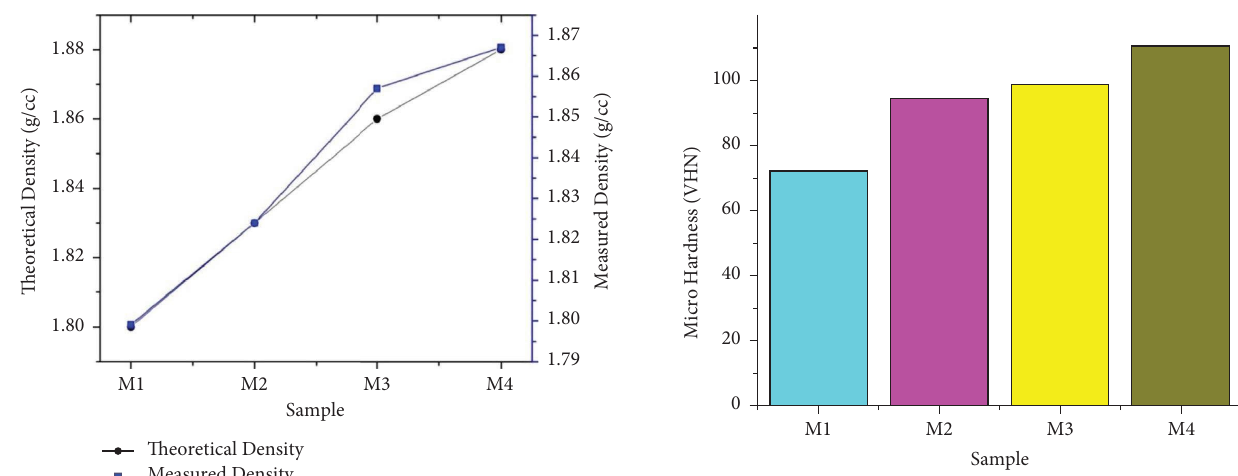
Figure 6: Variation of density of nanocomposites.